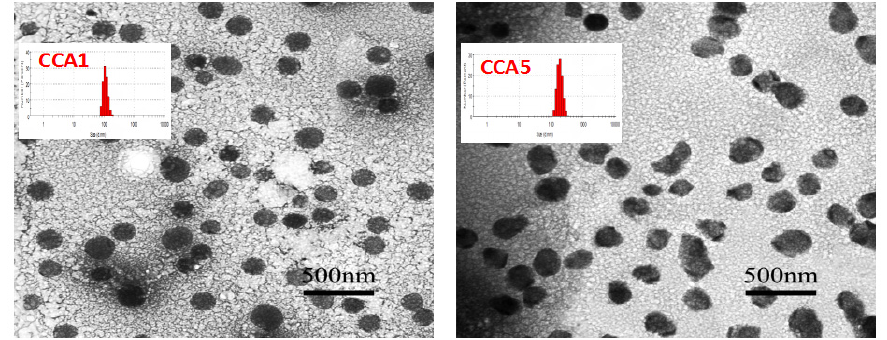
Figure 3. TEM of CCA1 and CCA5 nanoparticles.